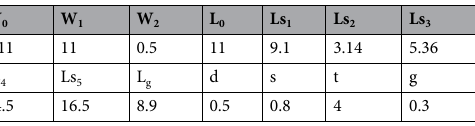
Table 1. Dimensions of the single-band power divider (unit: